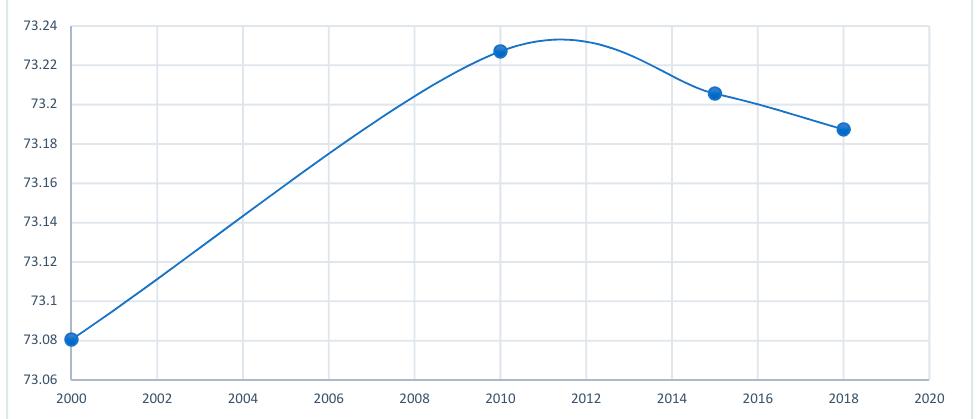
Figure 2. MGCI assessed from CCI-LC over time. Data points include 2000, 2010, 2015, and 2018.